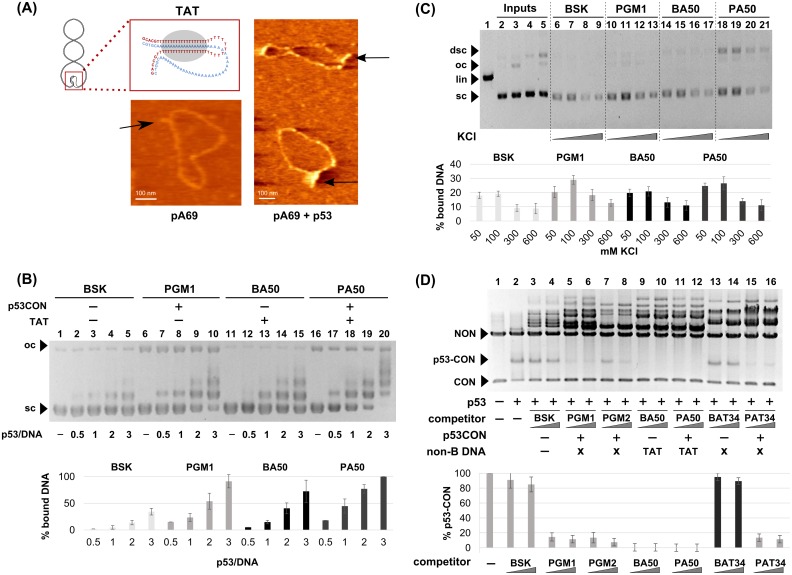
Binding of p53 to supercoiled DNA bearing homoadenine-homothymine triplex forming sequences.(A) Scheme of intramolecular T.A.T triplex in scDNA. AFM image of sc pA69 plasmid adsorbed on mica surface in the presence of 2 mM MgCl2 and complex of pA69 with p53. (B) Comparison of p53 binding to scDNA with and without triplex forming sequence (dA)50.(dT)50 by EMSA. Binding of p53 protein to pBSK, pPGM1, pBA50 and pPA50 detected by EMSA in agarose gel. p53 protein was bound to scDNA (pBSK, 200 ng, lanes 1–5), scDNA with CON (scPGM1, 200 ng, 6–10), scDNA with (dA)50.(dT)50 (scBA50, 200 ng, 11–15) and scDNA with both CON and (dA)50.(dT)50 (scPA50, 200 ng, 16–20) in p53/DNA molar ratios 1–3 at 4°C, EMSA was performed at 4°C. Graph represents the dependence of percents of bound DNA on the amount of p53 proteins calculated from three experiments. (C) Interaction of p53 with scDNA (BSK, PGM1, BA50 and PA50) in presence of pBSK/SmaI (linear competitor, lin) by immunoprecipitation on MBG. Agarose gel electrophoresis of DNA recovered from MBG after incubation of DO1-wtp53-DNA complex at the beads to 50, 100, 300 or 600 mM KCl for 30 min at 10°C followed by the SDS treatment. DNA inputs of scDNA BSK (lane 2), PGM1 (lane 3), BA50 (lane 4), PA50 (lane 5), linBSK (lane 1). Arrows indicate precipitated supercoiled (sc), open circular (oc), linear (lin) and supercoiled dimers (dimer sc). Mean values of bound DNA from three independent experiments were plotted in the graph. Graph represents the dependence of percents of bound DNA on the concentration of KCl in washing buffer calculated from three experiments. (D) Competition assay of p53 binding to CON and non-B-DNA structures in scDNA plasmids. First, full length p53 (60 ng) was incubated with 200 ng PGM1/PvuII fragments (short fragment with CON sequence (CON, 474 bp) and long fragment as linear nonspecific competitor (NON, 2513 bp) for 20 min on ice to form p53-CON complexes. Subsequently, 200 or 300 ng of different scDNA plasmid competitors were added and incubation was prolonged to 40 min. Plasmids forming triplex T.A.T were marked by TAT, plasmids forming cruciform by X. Graph represents the dependence of percents of bound DNA on the amount of used competitor scDNAs calculated from three experiments.